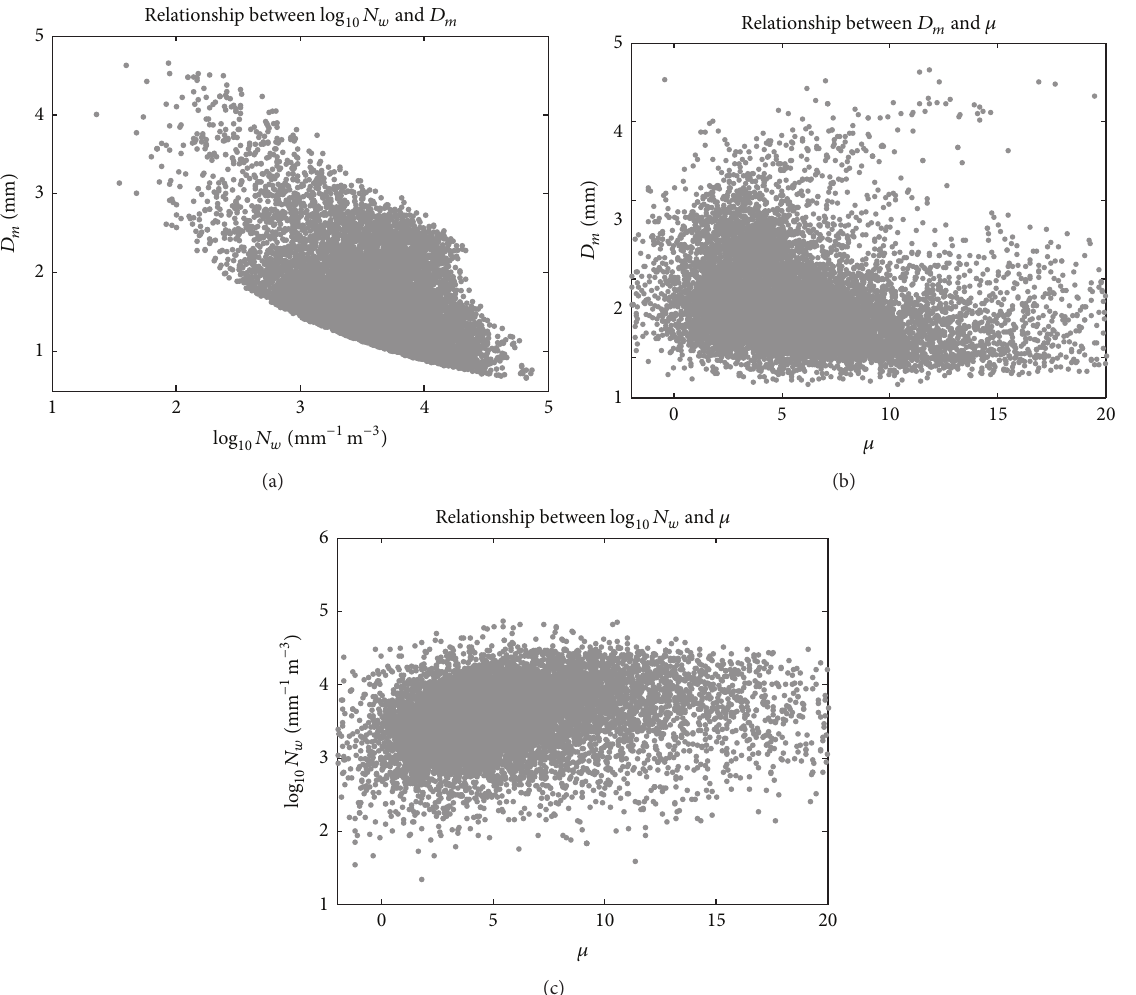
Figure 14: (a) Scatter plots of estimated normalized Gamma DSD parameters: 𝐷 𝑚 -log 10 𝑁 𝑤 values. (b) Scatter plots of estimated normalized Gamma DSD parameters: 𝐷 𝑚 - 𝜇 values. (c) Scatter plots of estimated normalized Gamma DSD parameters: log 10 𝑁 𝑤 - 𝜇 values.